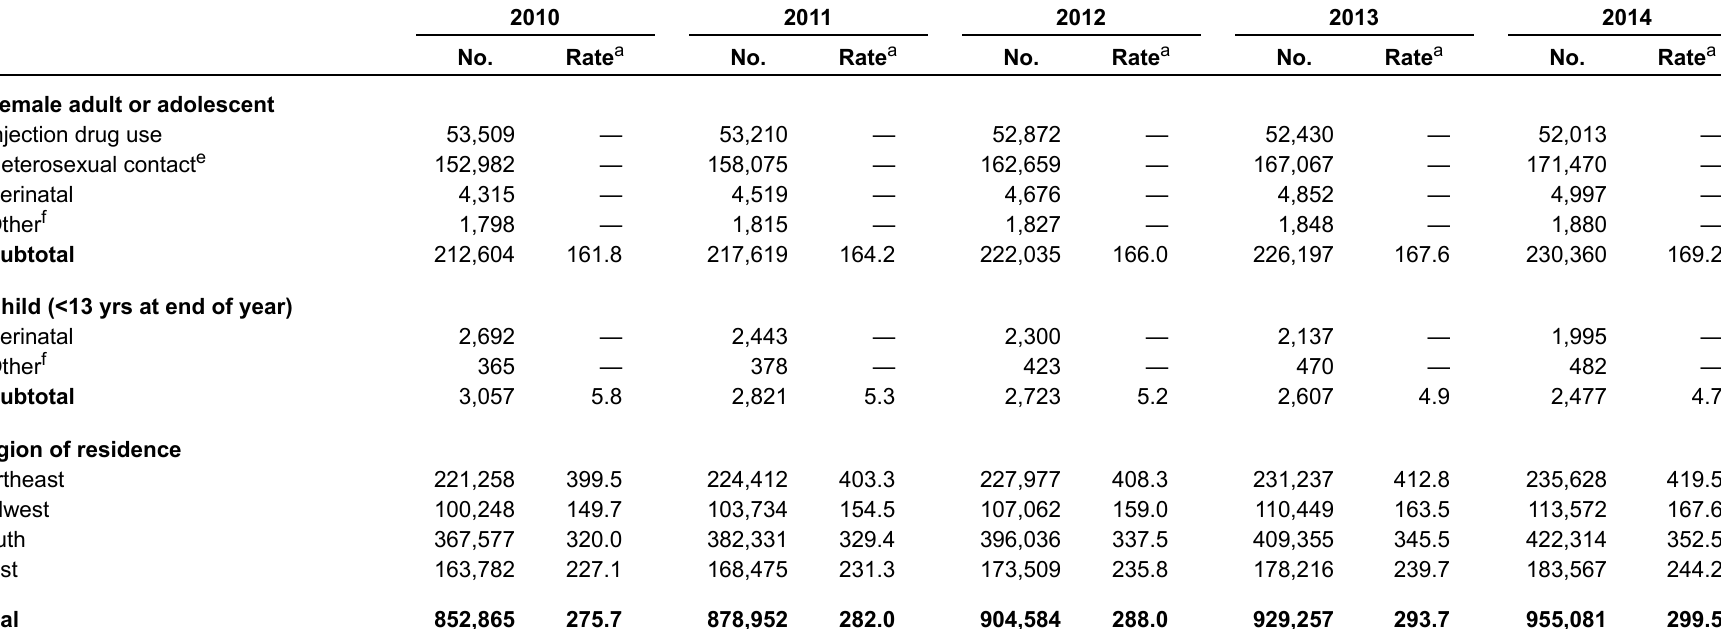
Table 18a. Persons living with diagnosed HIV infection, by year and selected characteristics, 2010–2014—United States